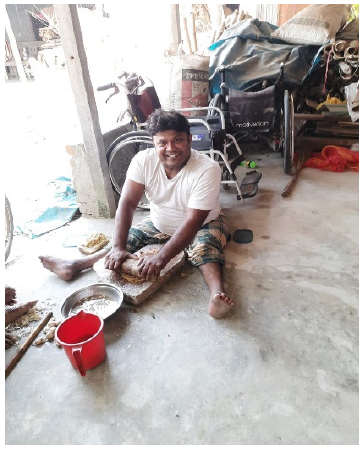
Figure 6. Alt-text: Members of Cultivation for Users Hope, three women and a man, standing together smiling in front of planted trees.